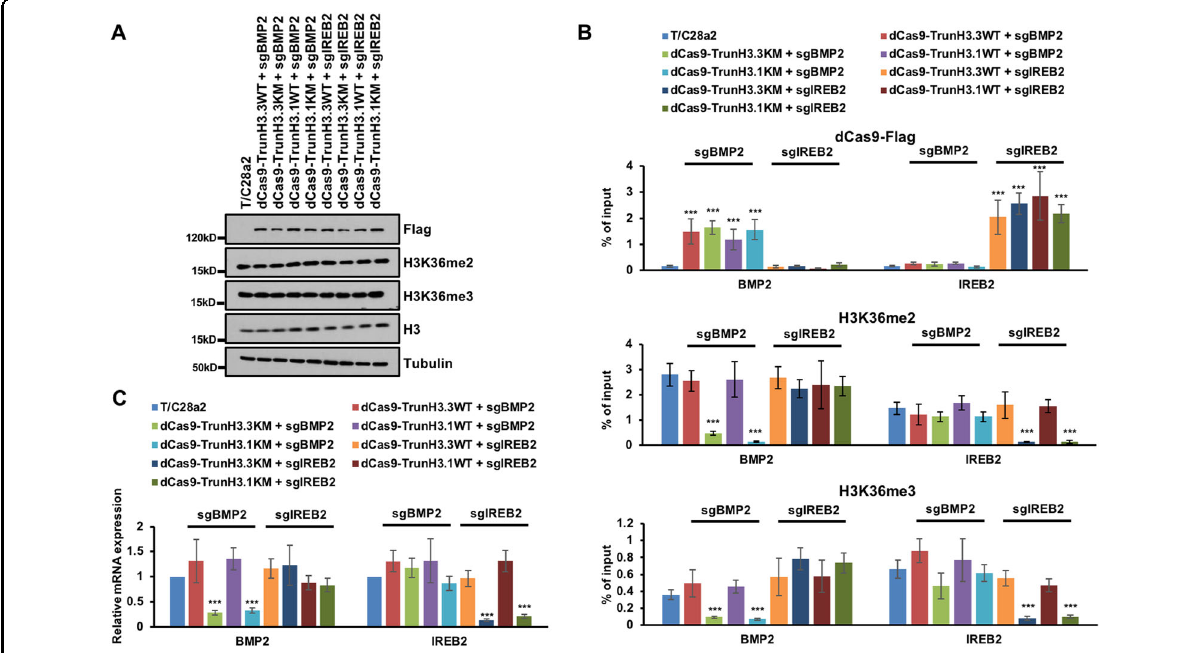
Fig. 7 Targeting H3K36M-mutant protein to chromatin inhibited the H3K36 methylation locally. A Targeting truncated H3.3K36M and H3.1K36M to BMP2 and IREB2 loci didn ’ t change the total level of H3K36 methylation. T/C28a2 cells were infected with lentivirus to overexpress dCas9-fused H3.3WT, H3.3K36M, H3.1WT, and H3.1K36M with BMP2 and IREB2 sgRNAs respectively. Cell extracts were analyzed by western blotting using the indicated antibodies. B Targeting truncated H3.3K36M and H3.1K36M to BMP2 and IREB2 loci inhibited the H3K36 methylation locally. Upper: ChIP-qPCR analysis of dCas9-fused proteins at BMP2 and IREB2 loci. Middle: enrichments of H3K36me2 at BMP2 and IREB2 loci. Lower: enrichments of H3K36me3 at BMP2 and IREB2 loci. Data are mean ± SD ( N = 3 independent replicates, *** p < 0.001). C The expressions of BMP2 and IREB2 decreased after targeting truncated H3.3K36M and H3.1K36M to BMP2 and IREB2 loci, respectively. The expressions of BMP2 and IREB2 were analyzed by quantitative RT-PCR and normalized to GAPDH. The expression levels of the genes in T/C28a2 cells were normalized as 1. Data are mean ± SD ( N = 3 independent replicates, *** p <